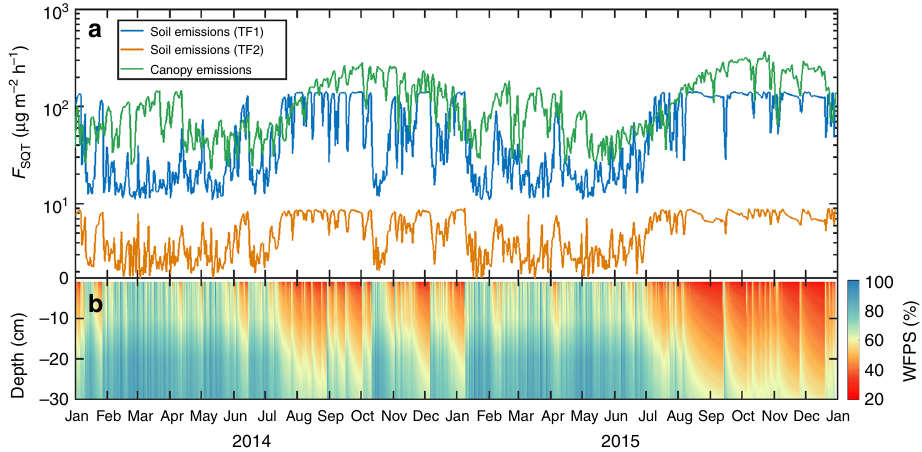
Fig. 6 Daily averages of SQT emissions from ATTO soils and treetop canopy. Emissions from TF1 (blue line; a ) and TF3 (orange line; a ) were simulated with the use of WFPS at the ATTO site ( b ). Canopy emissions (green line) were calculated with the MEGAN model. WFPS is a result of hydrological modeling over the volumetric water content data at the ATTO